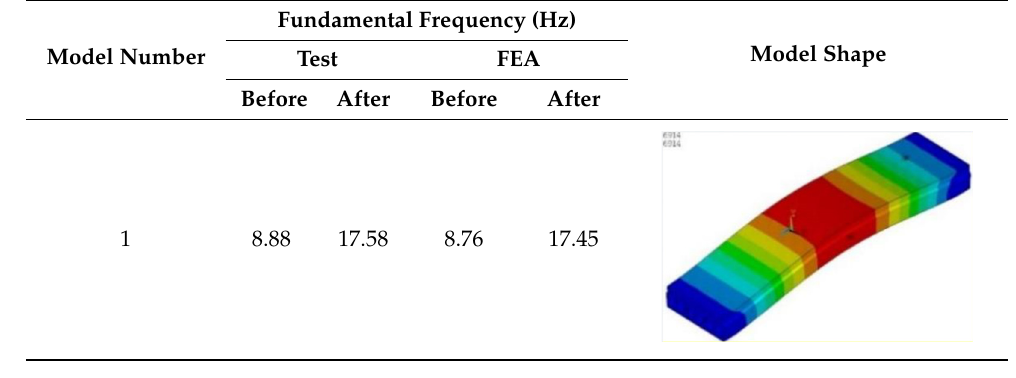
Table 3. Fundamental frequency results.